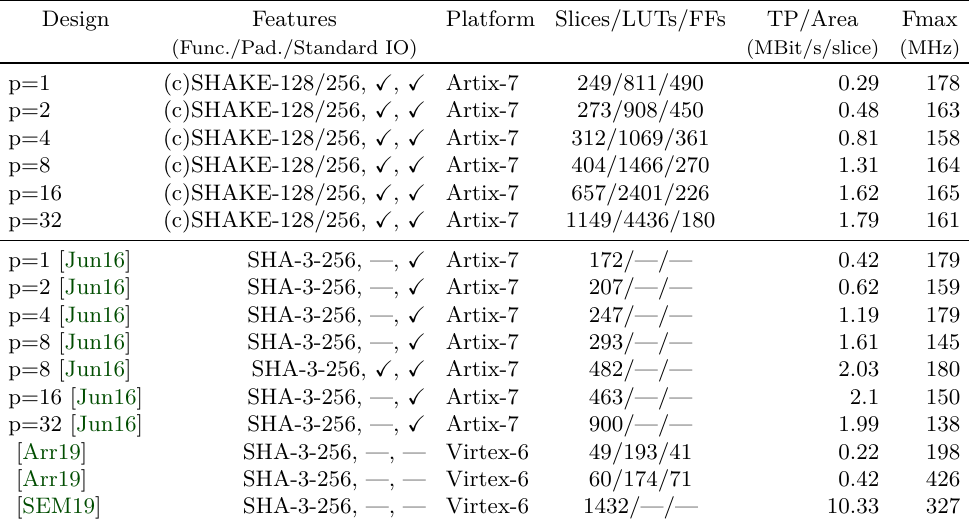
Table 3: Performance of the proposed SHAKE hardware module and comparison with state-of- the-art related